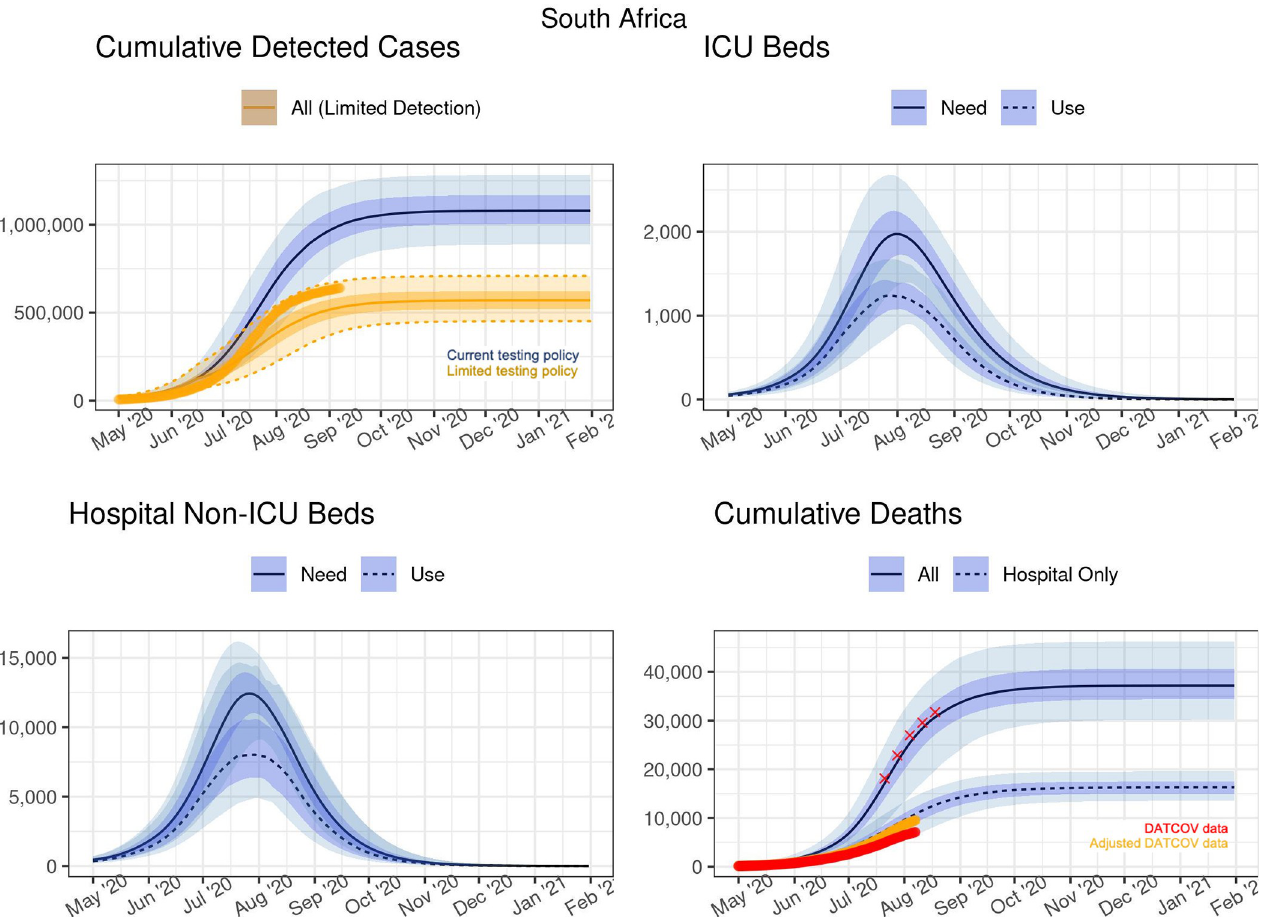
Fig 4. Projected cases and inpatient bed need and use at the national level. The red crosses in the bottom right-hand panel represents 80% of the excess deaths found in the SAMRC